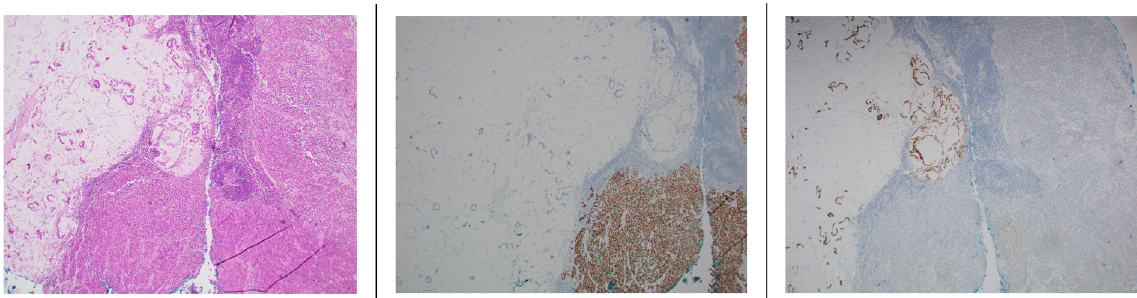
Figure 1. Histologic examination of an excisional lymph node exhibiting contiguous areas of both adenocarcinoma and squamous cell carcinoma. ( Left panel ) representative H&E section. ( Middle panel ) the same section with p40 staining of the squamous cell carcinoma. ( Right panel ) the same section distinguishing areas of CDX2 staining of the adenocarcinoma.